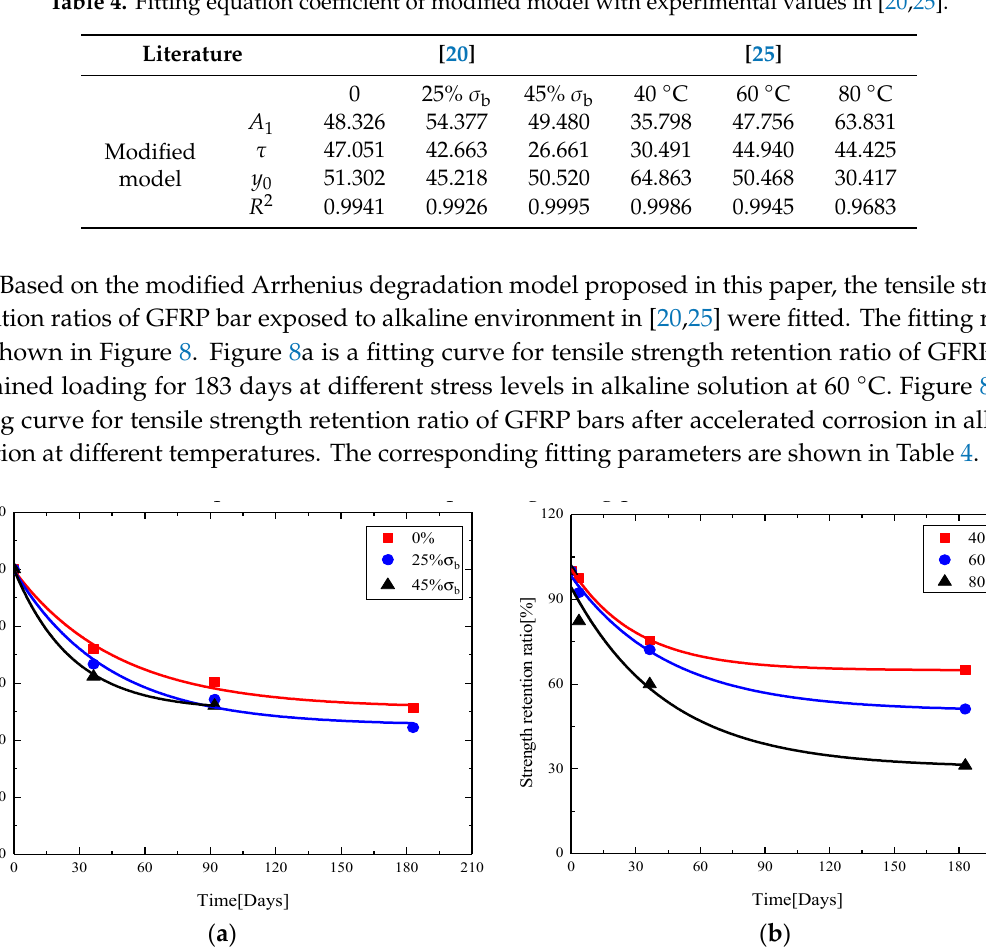
Table 5. Coe ffi cient of modified model for fitting equation with experimental values of other